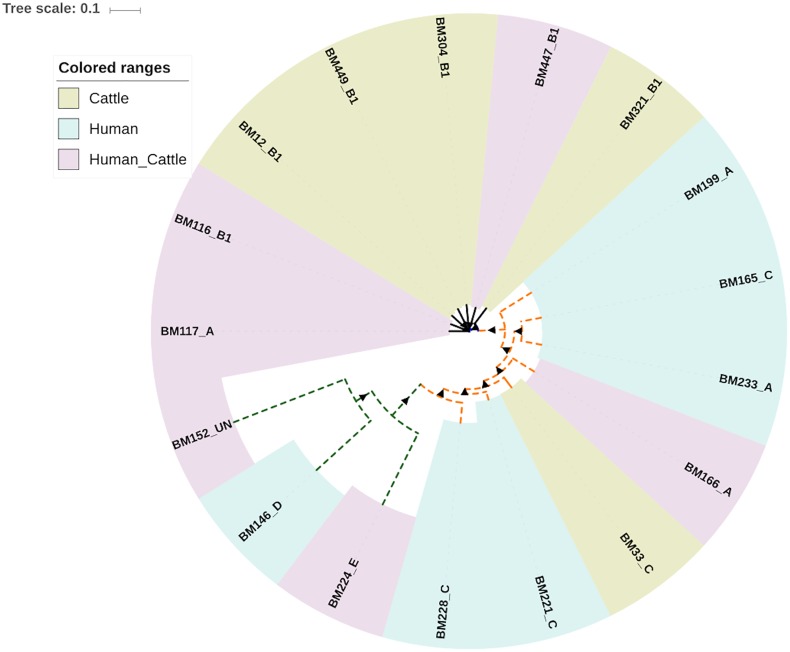
Evolutionary relationship of 17 commensal E. coli isolates sequenced in this study.Evolutionary relationship between 17 sequenced strains of Escherchia coli from cattle and cattle attendant in Tanzania was inferred using CSI phylogeny. Three clusters I, II and III are indicated in green, blue and orange lines respectively. Isolates obtained from human are indicated with dashed lines, and from cattle—with solid lines. The coloured ranges represent either host specific or shared ERIC-PCR types. Triangles show bootstrap support in a range from 87 to 100. An image was created using iTOL [29].